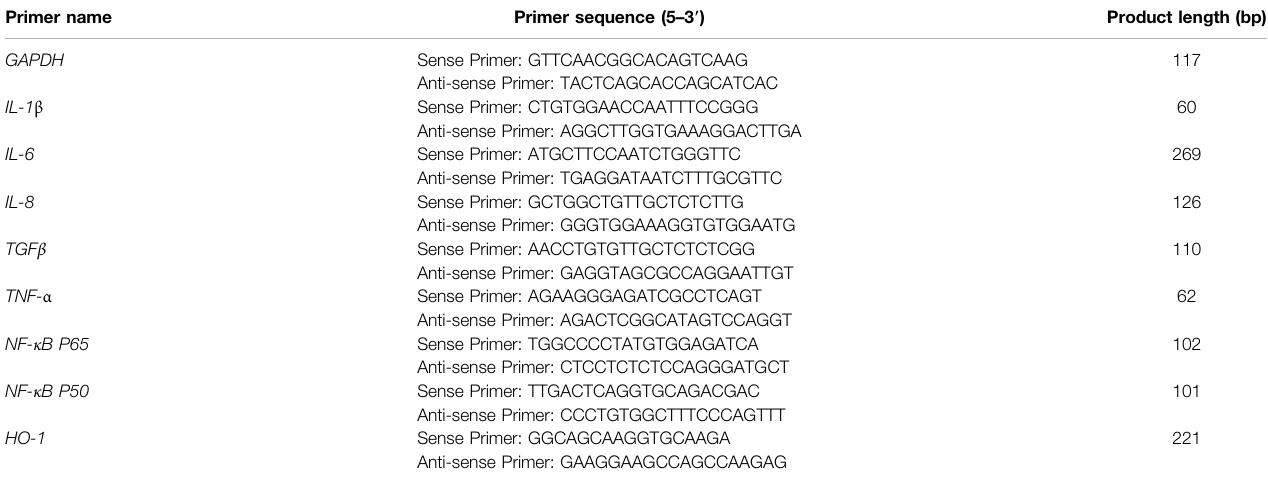
TABLE 1 | Primers for